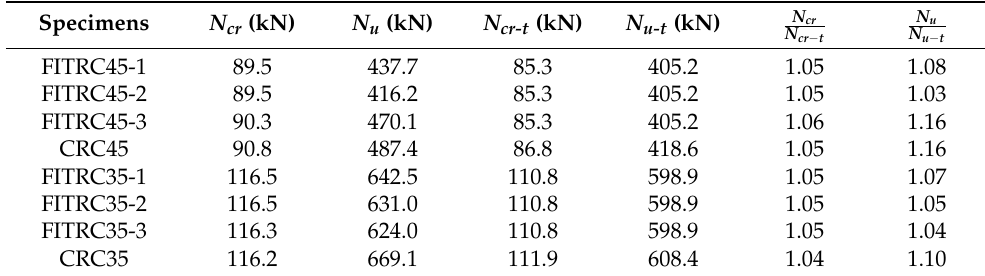
Table 9. Bearing capacity of RC columns.